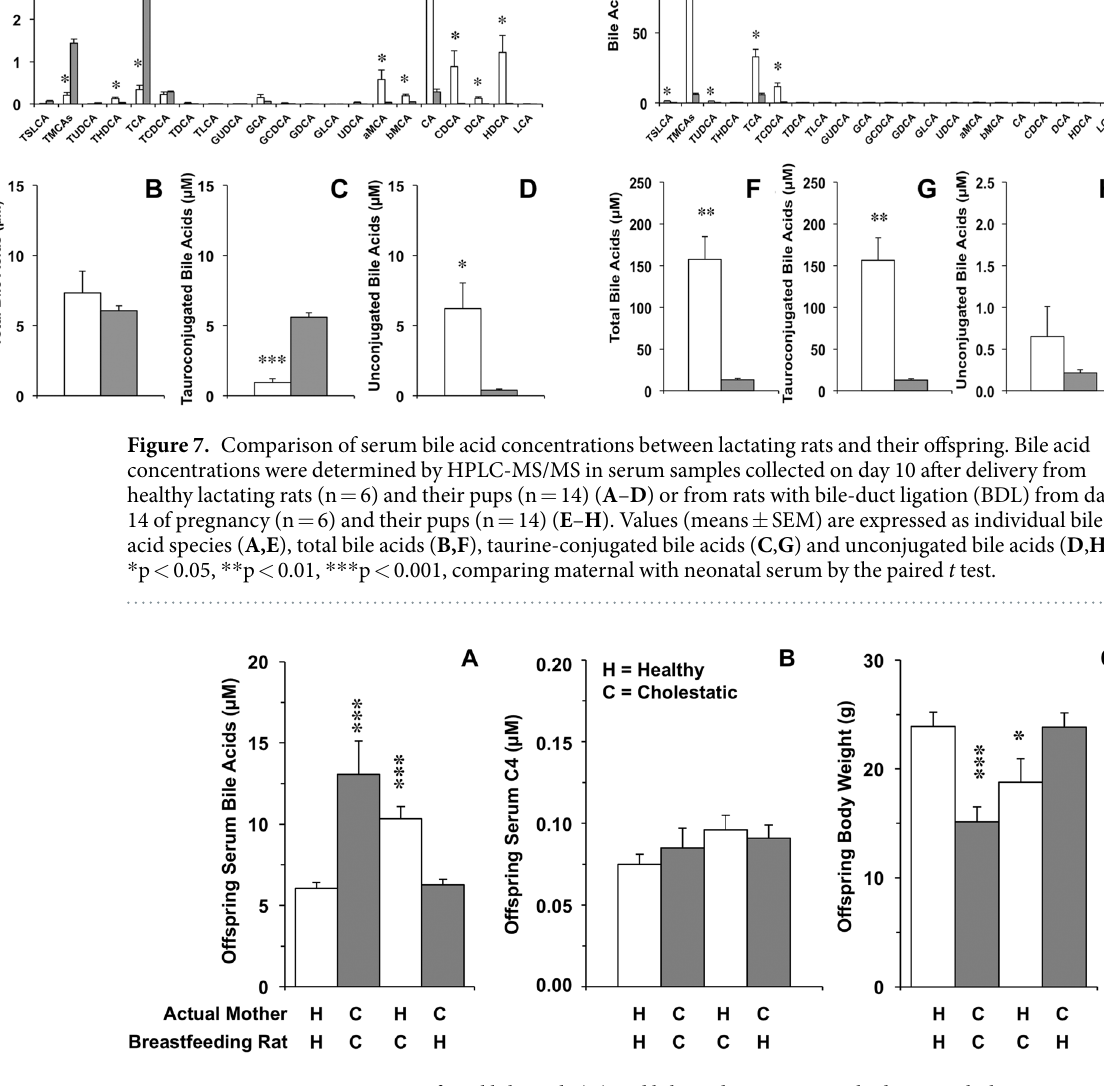
Figure 8. Serum concentrations of total bile acids ( A ) and bile acid precursor 7 α -hydroxy-4-cholesten-3-one or C4 ( B ) and body weight ( C ) of the offspring of healthy control ( H ) and cholestatic ( C ) lactating rats on day 10 after delivery. Obstructive cholestasis was imposed on the mothers by bile-duct ligation on day 14 of pregnancy. In two additional groups litters and mothers were exchanged immediately after delivery in order to impose breastfeeding of pups born from H rats by C rats and pups born from C rats by H rats. Bile acids and C4 were measured by HPLC-MS/MS. Values are means ± SEM of serum samples obtained from 8 to 14 pups belonging to 5 to 7 different litters in each case, * p < 0.05, *** p < 0.001, compared with control by the Bonferroni method of multiple-range